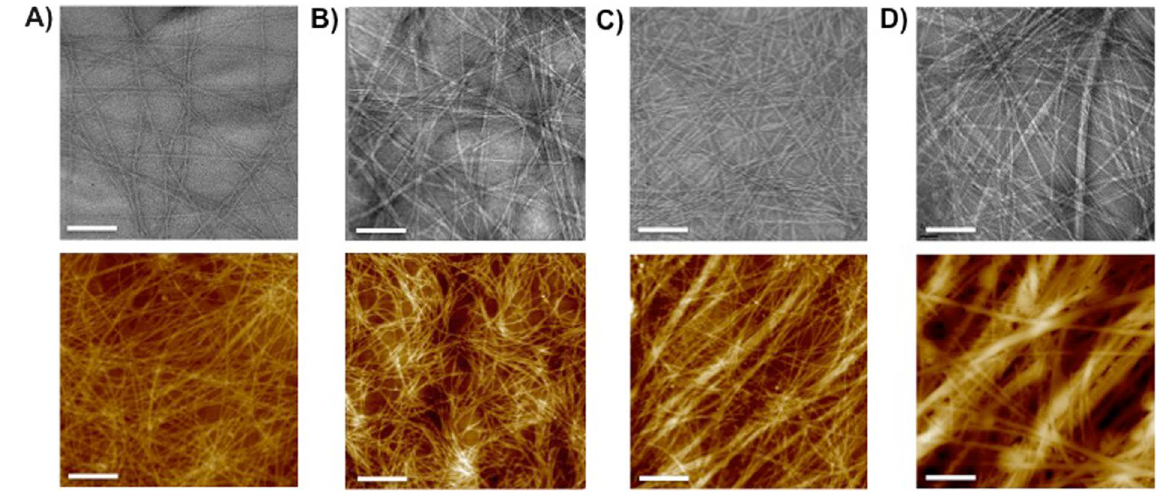
Figure 2. Nano- and microstructure of hydrogels (top panel TEM and bottom panel AFM): ( A ) 10 mg/mL Fmoc-FRGDF shows individual fibrils randomly interacting to form a matrix; ( B ) + 2 mg/mL shows a small increase in thicker bundles where individual fibrils have aligned ( C ) + 5 mg/mL and ( D ) + 10 mg/mL fucoidan show a large number of thick bundles and respectively fewer individual fibrils. TEM scale bar represents 50 nm, AFM 1 µ